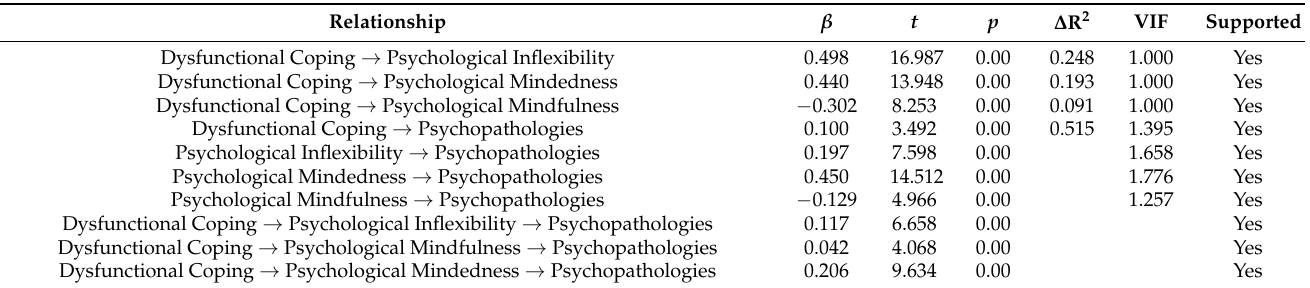
Table 4. Results of direct and indirect